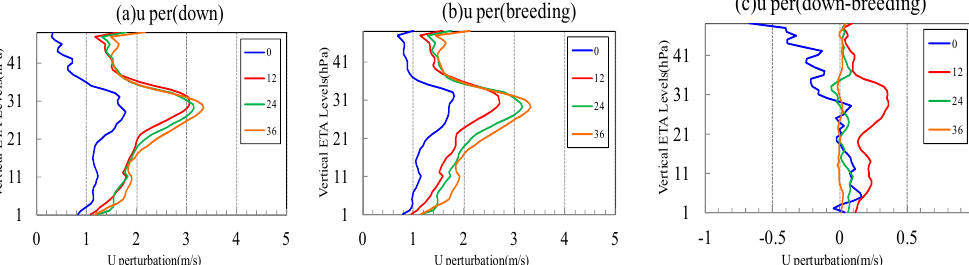
Figure 4. Vertical distributions of the zonal wind perturbation (unit: m·s-1); the different lines denote different forecast lead times. (a) Down; (b) Breeding; and (c) Down minus Breeding.